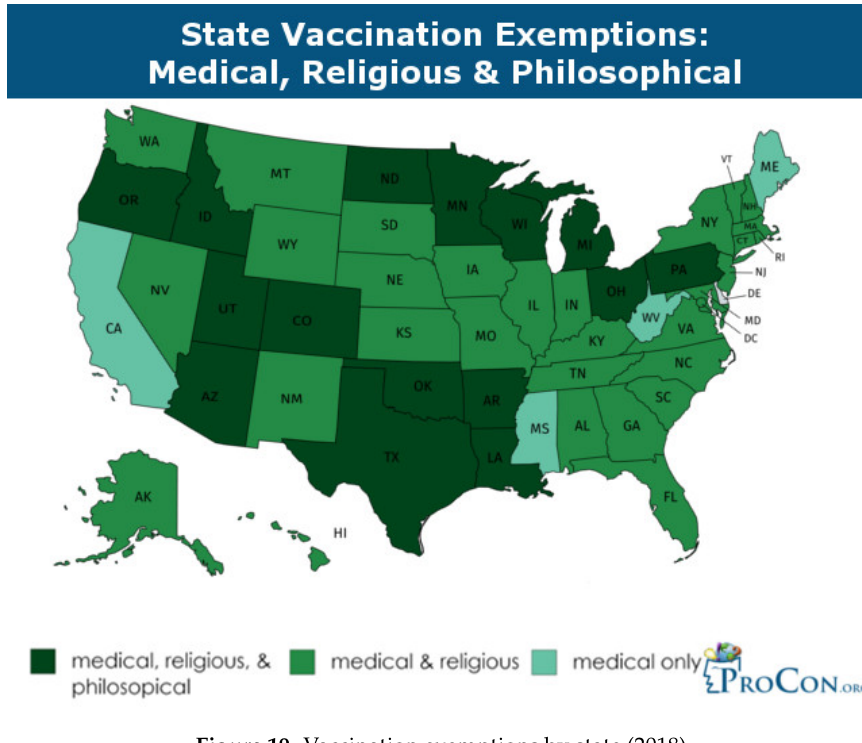
Figure 19. Vaccination exemptions by state (2018).